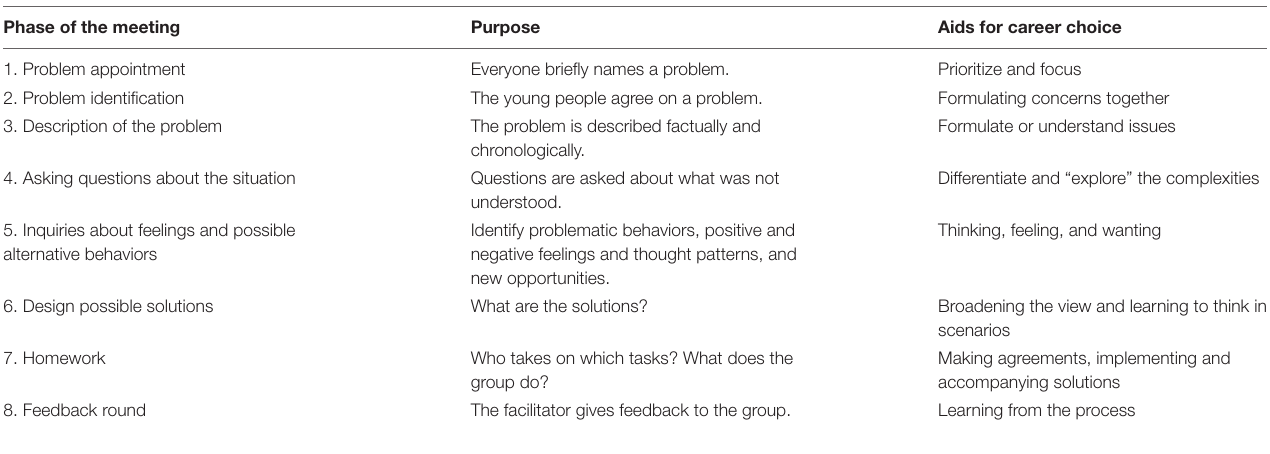
TABLE 1 | Procedure of the group